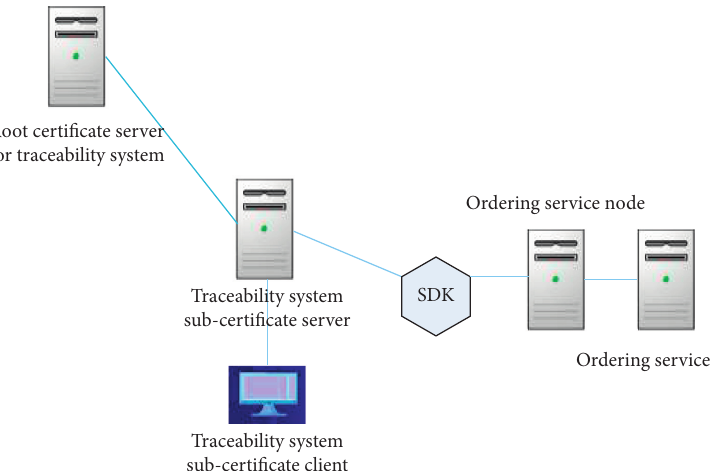
Figure 1: Blockchain traceability system deployment architecture